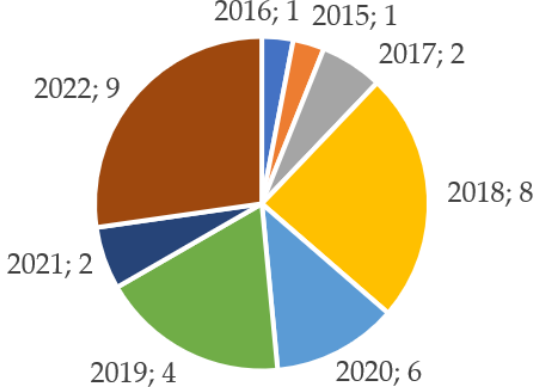
Figure 1. Diagram created using PRISMA that shows the systematic research’s findings.